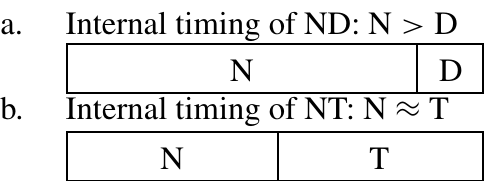
Figure 3: Internal timing of NCs (from Stanton 2016, 1092)